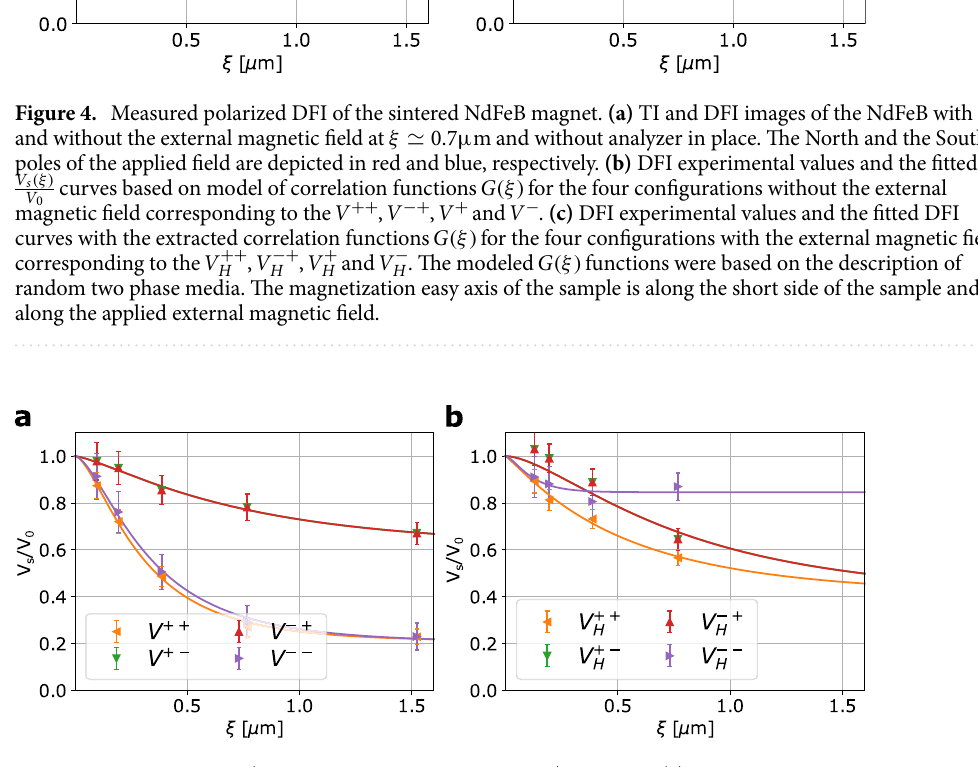
Figure 5. (a) Retrieved V +− and V −− from the measured V + , V − and V ++ , without the external magnetic field. (b) Retrieved V +− H and V −− H from the measured V + H , V − H and V ++ H , with the applied external magnetic field. The G (ξ) functions were extracted by fitting the model for random two phase